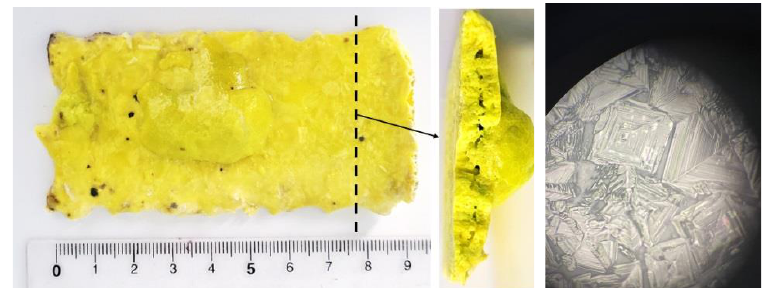
Figure 5. Photographs of YAG:Ce ceramic sample synthesized at E = 2.5 MeV, P = 37 kW/cm 2 . On the right is a photograph of the outer surface of the ceramic sample taken by optical microscope.